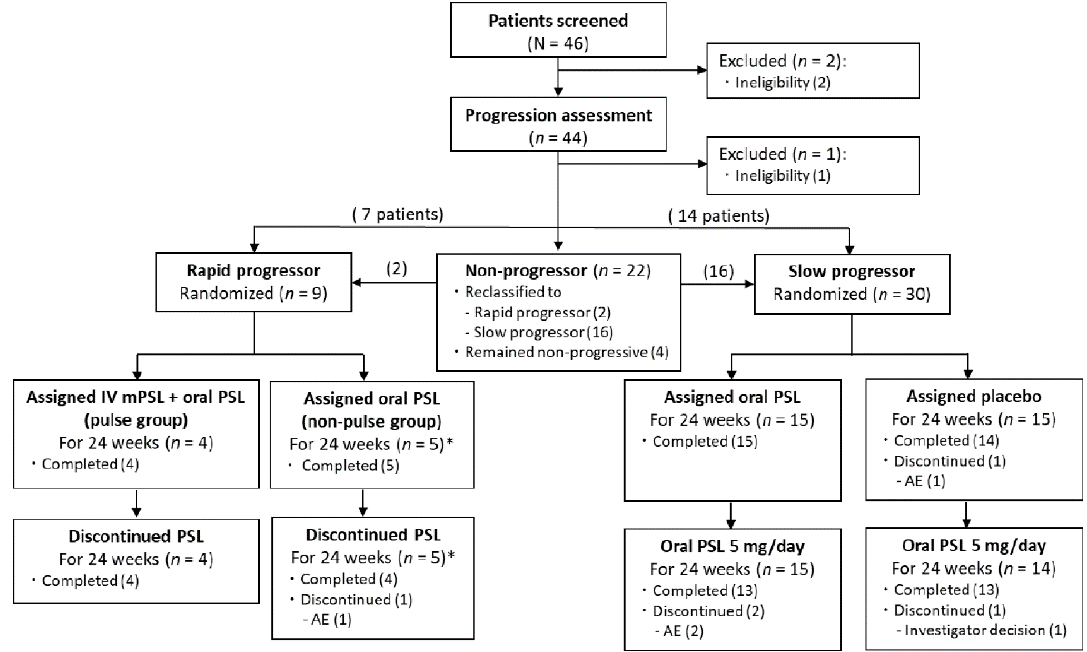
Figure 1. Trial flow chart. * One of five rapid progressors in the non-pulse group was excluded from the full and per-protocol sets due to ineligibility associated with treatment with carbamazepine (a strong CYP3A4 inducer) throughout the trial. AE, adverse event; IV mPSL, intravenous methylprednisolone; PSL, prednisolone.